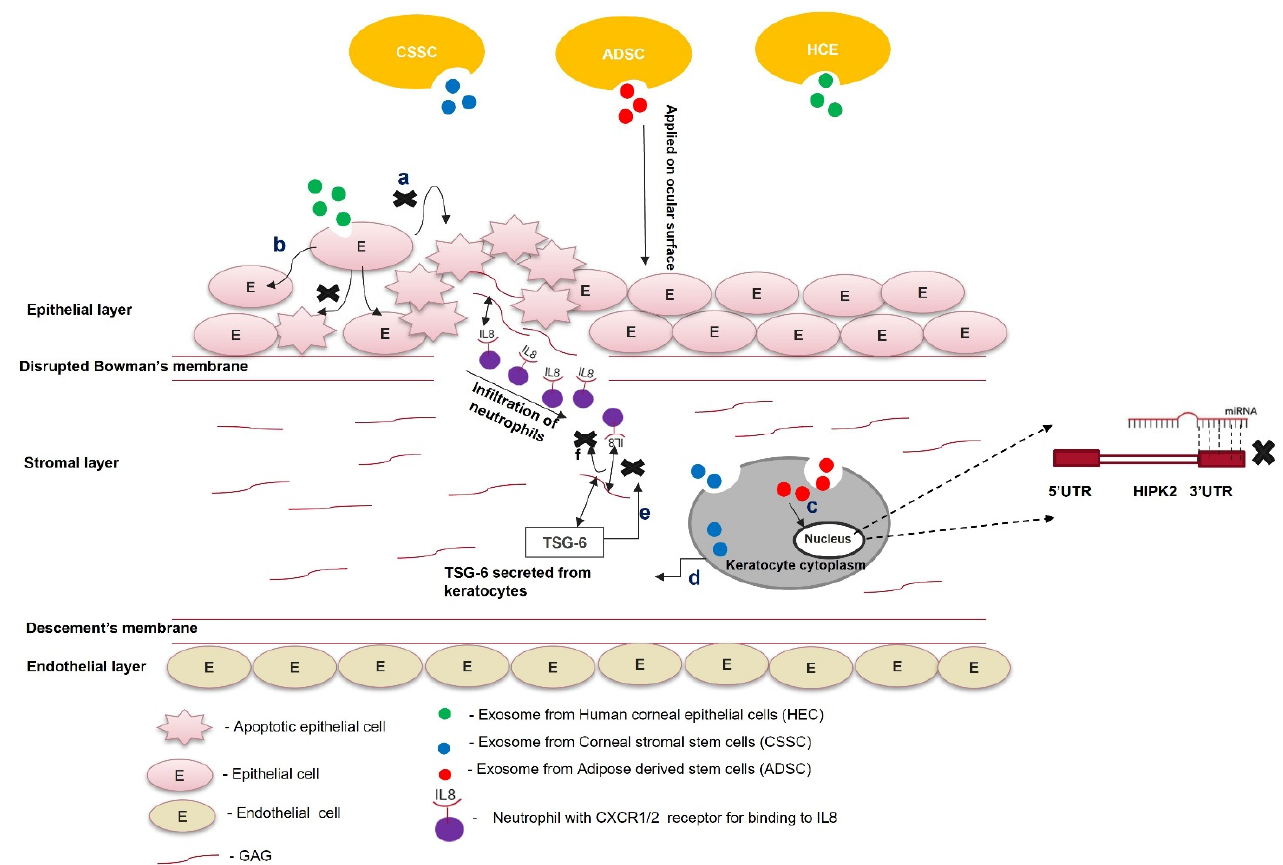
Figure 3. Role of exosomes in the treatment of scars. Exosomes from different cell types (ADSCs, CSSCs, and HECs) are loaded within the fibrin gel or encapsulated in the hydrogel and applied on the ocular surface; ( a ) exosomes from HECs taken up by the epithelial cells prevent paraptosis (apoptosis caused by hypoxic conditions); ( b ) epithelial cells treated with exosomes do not undergo apoptosis; ( c ) exosomes from ADSCs contain miR-19a, which post-transcriptionally silences HIPK2 and attenuates the JNK pathway; ( d ) exosomes from CSSCs contain TSG-6 protein, and once they are taken up by keratocytes, the TSG-6 proteins are secreted within them; ( e ) TSG-6 protein binds to GAG via its LINK domain and prevents the binding of IL8 to the GAG of corneal stroma; ( f ) the unbound form of IL-8 cannot be presented to the CXC1/2 receptor of neutrophils. It attenuates the infiltration of neutrophils to the wounded area of the cornea.